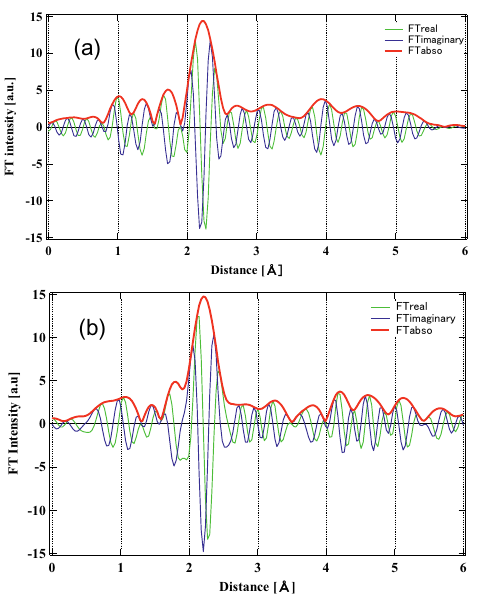
Figure 5. Simulated XAFS χ function weighted with photoelectron wave number k 3 for ZnSnAs 2 thin films doped with 5.0% and 6.5 %